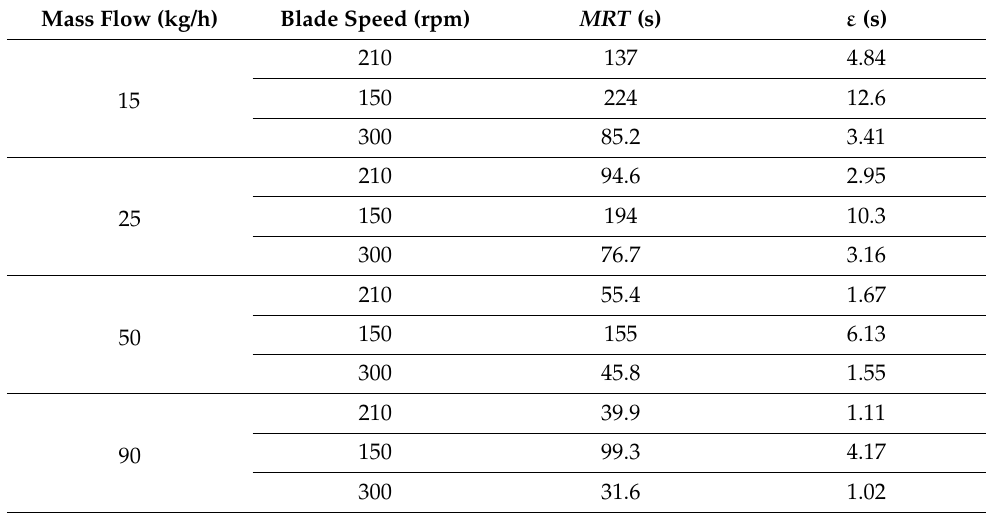
Table 3. Regressed Mean Residence Time Values and Goodness-of-Fit Values for Blender 2. Mass Flow (kg/h)